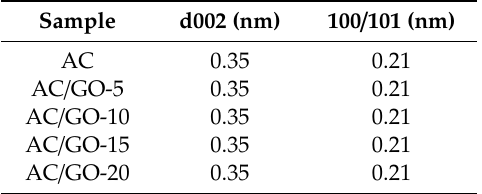
Table 1. Interlayer spacing with reference to additive.